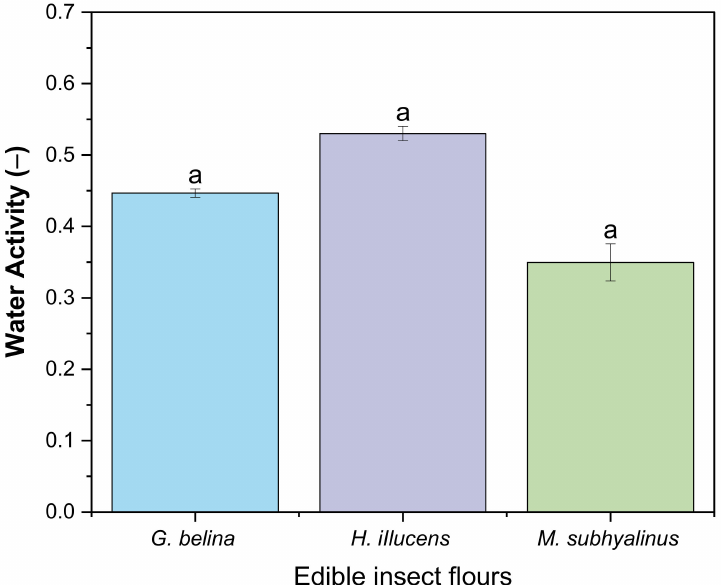
Figure 2. Water activity of three edible insect flours. Values are mean ± standard deviation, means with different superscripts are significantly different ( p <